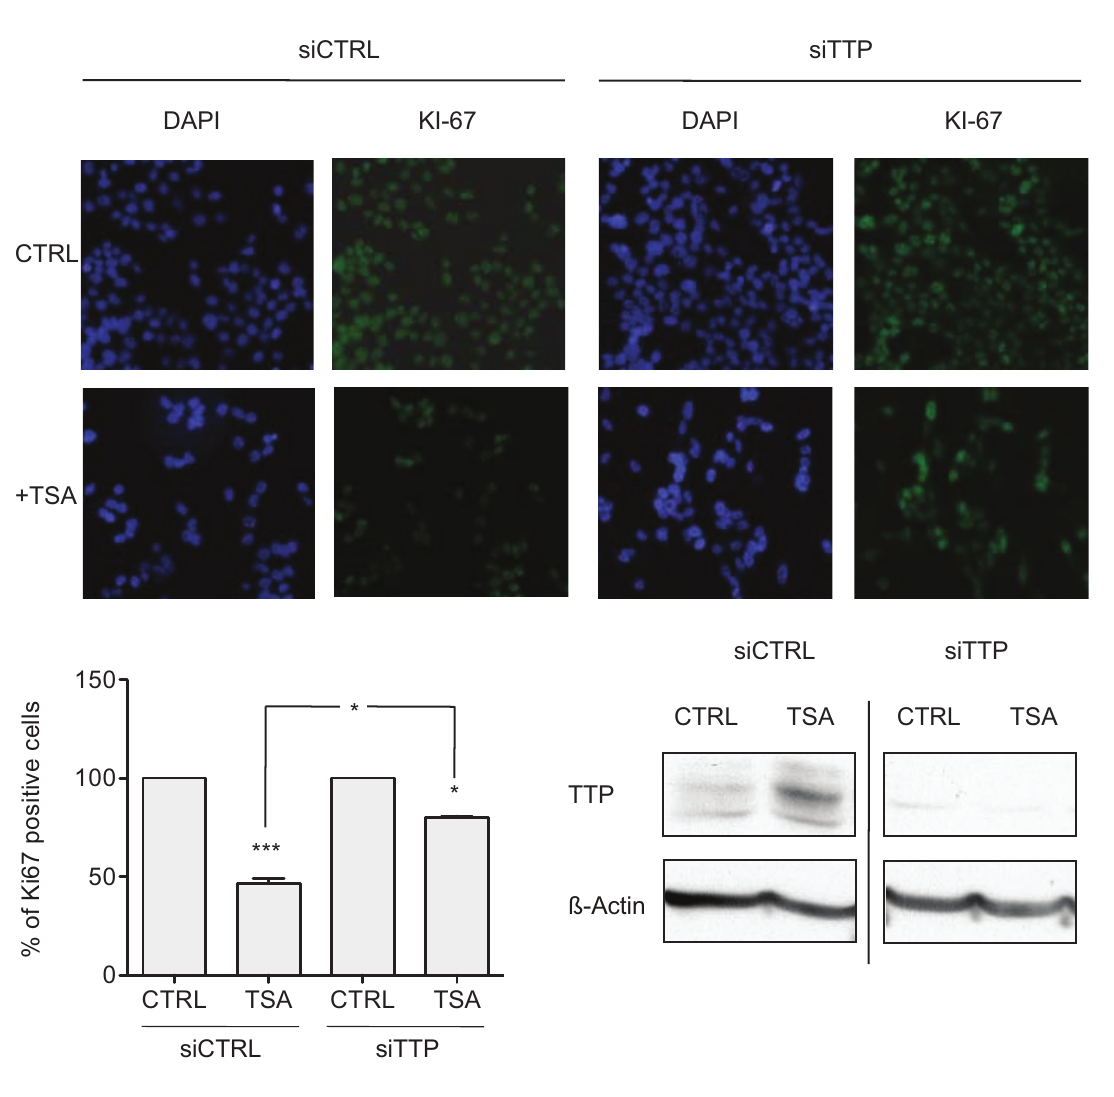
Figure 4. TSA-induced expression of TTP promotes growth inhibition. Immunofluorescent detection of Ki-67, shown in green, in HCT116 cells transfected with control siRNA or TTP siRNA for 24 h and then treated with 0.4 (cid:3)M TSA for additional 24 h. DAPI nuclear staining is shown. Bar graphs represent the average percentage of Ki-67 positive cells per field ± SD ( n = 3 fields) of 3 independent experiments. The efficiency of TTP knockdown is shown by Western blot of TTP expression after 24 h of siRNA transfection followed by 12 h of TSA treatment. The data represent the mean of three independent experiments (± SD). * p < 0.05, *** p <